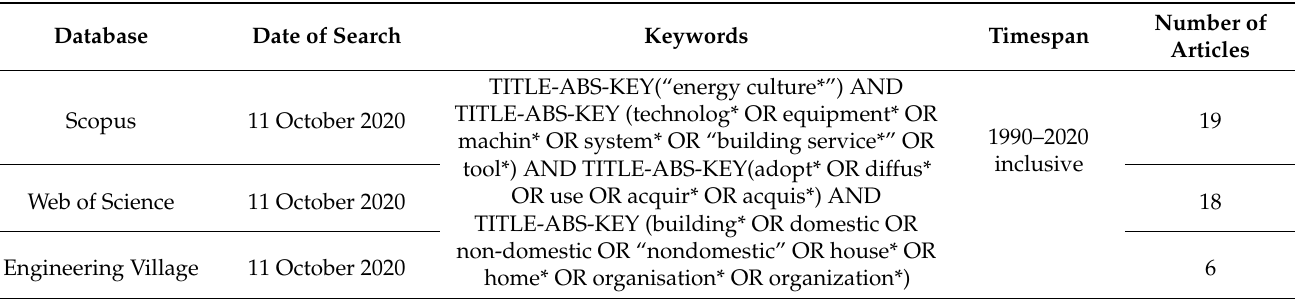
Table 3. Scoping review searching